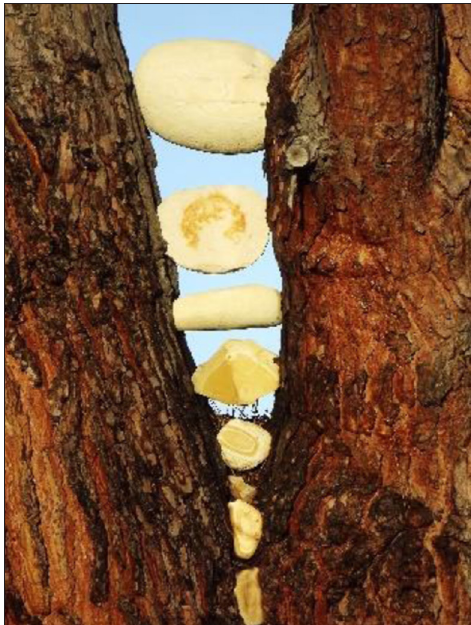
Figure 2: Rock climbers in tree. Photo: Paul